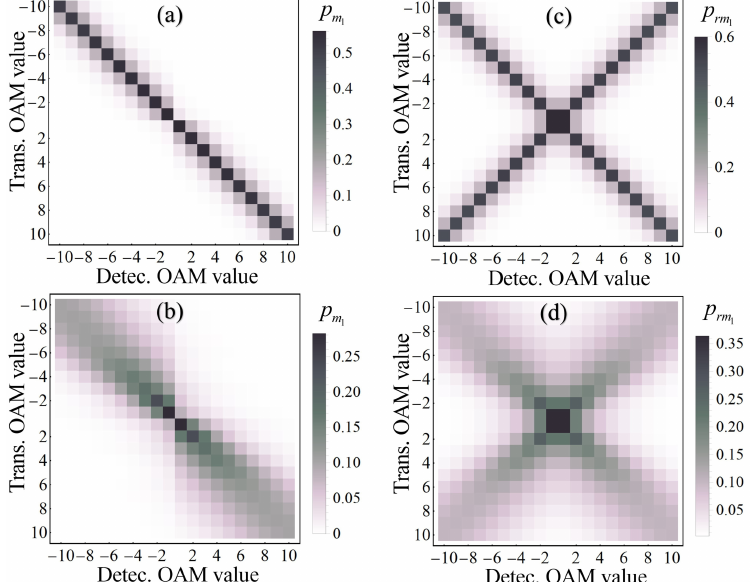
Figure 4. Relative detection probability under oceanic turbulence of the single photon ( a , b ) and bi-photon entangled Airy beams ( c , d ) (for OAM, | m 1 (cid:105) detections are plotted as the leading diagonal elements, while | m 2 (cid:105) detections as the minor diagonal elements). With a propagation distance from z = 10 m ( a , c ), increasing to z = 50 m ( b , d